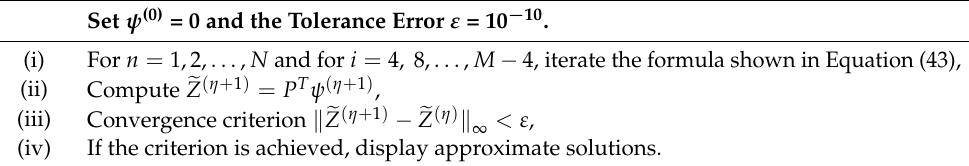
Table 1. QSPSOR computational